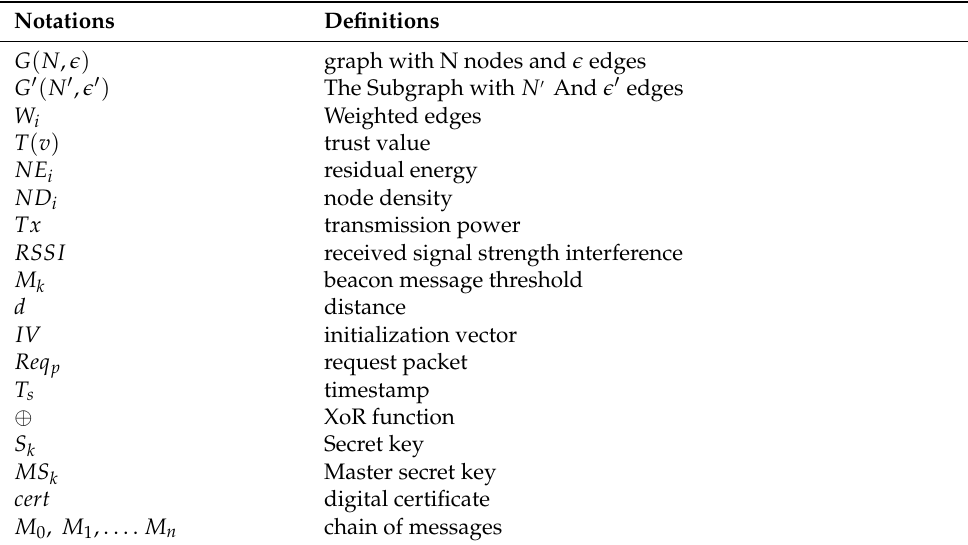
Figure 2. Communication flow of the AI-EPP algorithm. Table 1. List of notations.